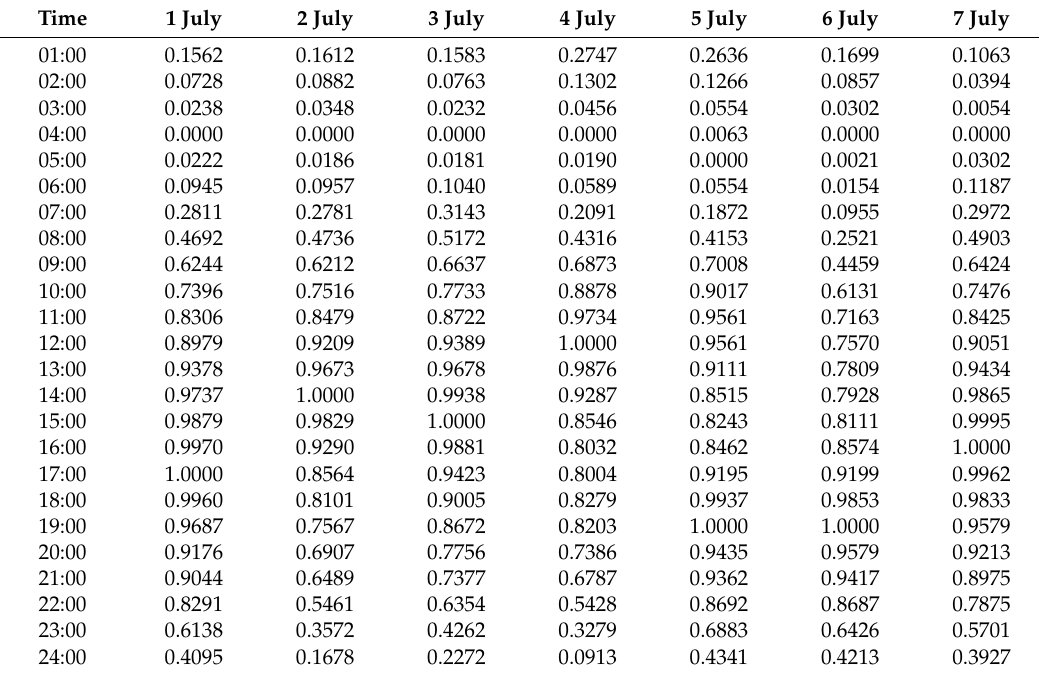
Table 3. Normalization values of load data for GEFCom2014